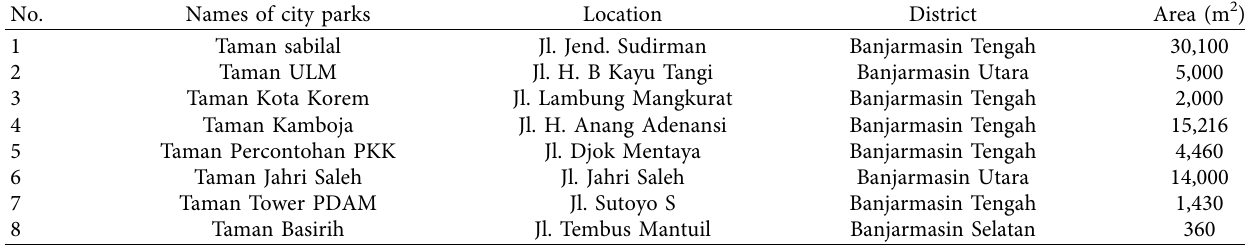
Table 7: Te list of city parks in Banjarmasin city in 2013.